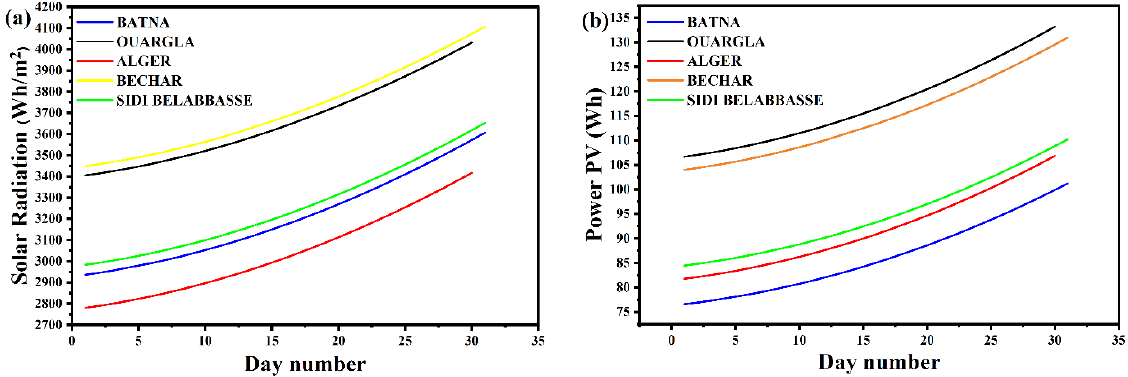
Figure 5. Monthly evolution of ( a ) solar radiation and ( b ) power PV at different sites in Algeria (January 2022).